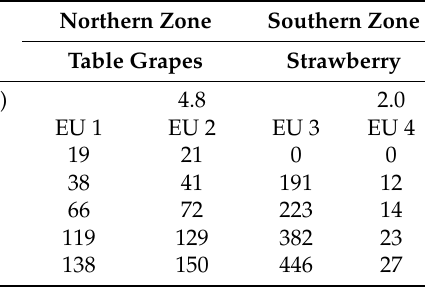
Table 4. Monthly electrical energy demand (kWh/month) for irrigation in each EU.